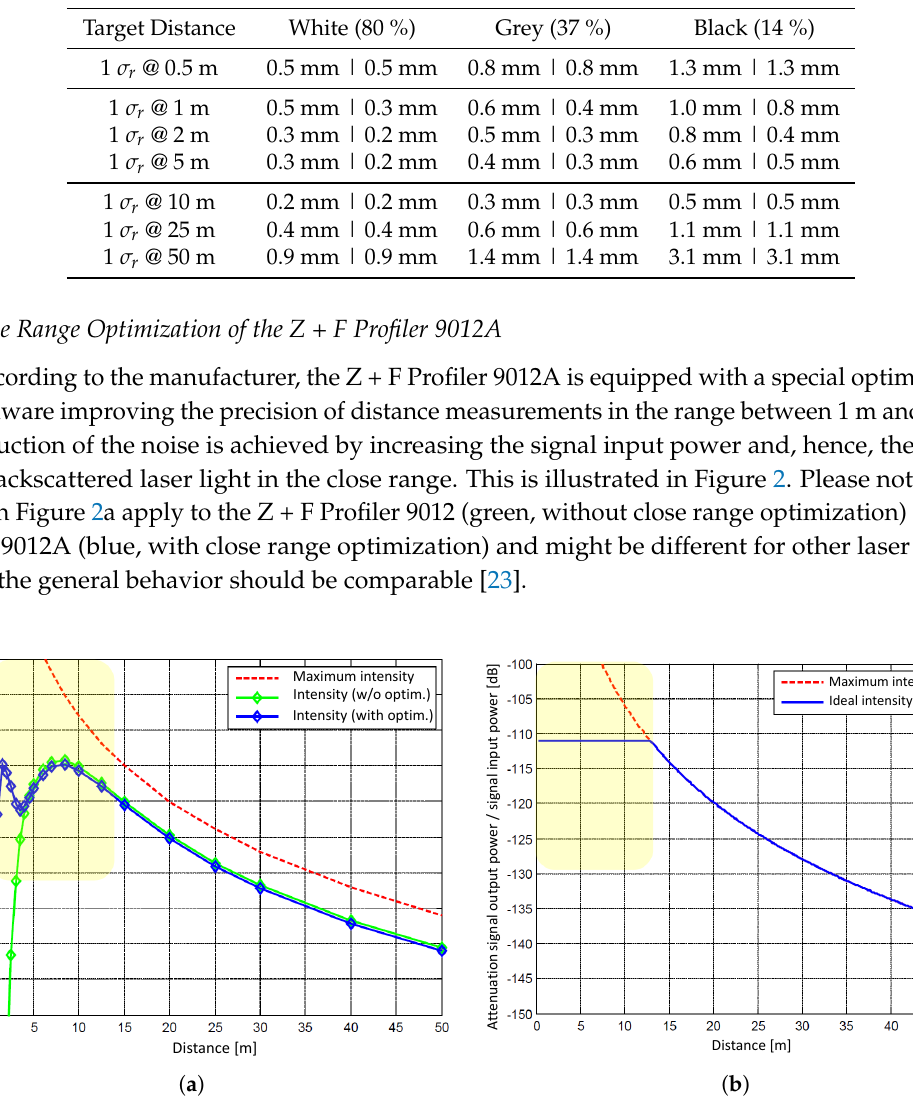
Table 2. Specified standard deviations σ r of the distance measurements for a standard scan rate of 127 kHz for different distances as well as reflectivities of the surface. The values are stated for both Z + F Profiler 9012/9012A (without/with close range optimization) and have to be converted to the actual scan rates of 254 kHz, 508 kHz or 1016 kHz by using the factors from Table 1 (according to [27]). Z + F Profiler Z + F Profiler Distance Noise